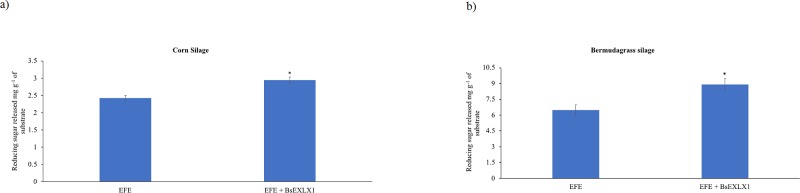
a and b. Synergistic hydrolytic effects of an exogenous fibrolytic enzyme (EFE) preparation and bacterial expansin-like protein (BsEXLX1; 100 μg/g DM) on a) whole-plant corn silage and b) bermudagrass silage under simulated ruminal conditions of dairy cows (pH 6.0, 39°C, 12 h, N = 4). Symbols on bars indicate differences (P < 0.05) between treatments (Experiment 4) the P-value for EFE× BsEXLX1 interaction was < 0.05. Reducing sugars were expressed as glucose equivalent/g substrate. Sugar values from control and BsEXLX1 only were equal to zero hence these were not presented.